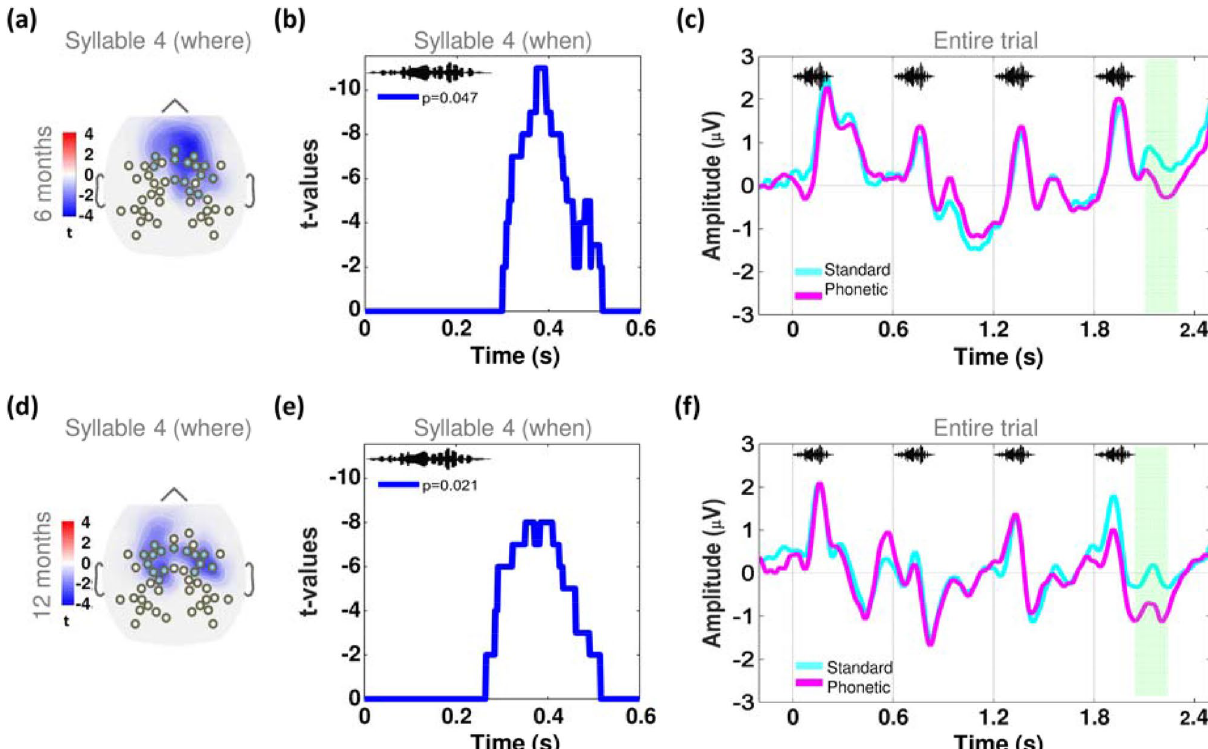
Figure 2. The spatiotemporal clusters for the analysis of the phonetic MMR was similar at 6 and 12 months of age. By applying the cluster-based permutation technique we identified where (i.e. the electrodes) and when (i.e. the time window) the brain response to the syllable 4 differed between the phonetic and standard trials, computed across all infants, regardless of the group (hRSV and control) and type of phonetic contrast (native and nonnative), at 6 and 12 months of age. The t -maps plotted in ( a ) and ( d ) show the group of the frontal electrodes where the standard and phonetic trials differed at syllable 4, at 6 and 12 months of age, respectively, and in ( b ) and ( e ) we depict the t -values indicating the time windows when those differences remained significant, at p < 0.05, FDR corrected. In ( c ) and ( f ) we plot the time course of the grand average of the voltage amplitude for the entire standard and phonetic trials, computed over the spatiotemporal cluster corresponding to age. The soundwave images indicate the occurrence of each one of the 4 syllables of the trials. The green rectangle highlights the time window when the brain response to the standard and phonetic trials